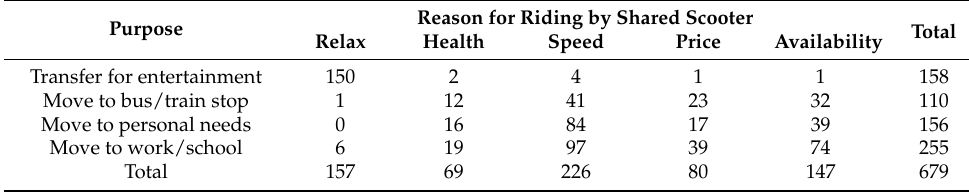
Table 6. The reason for using shared scooters.